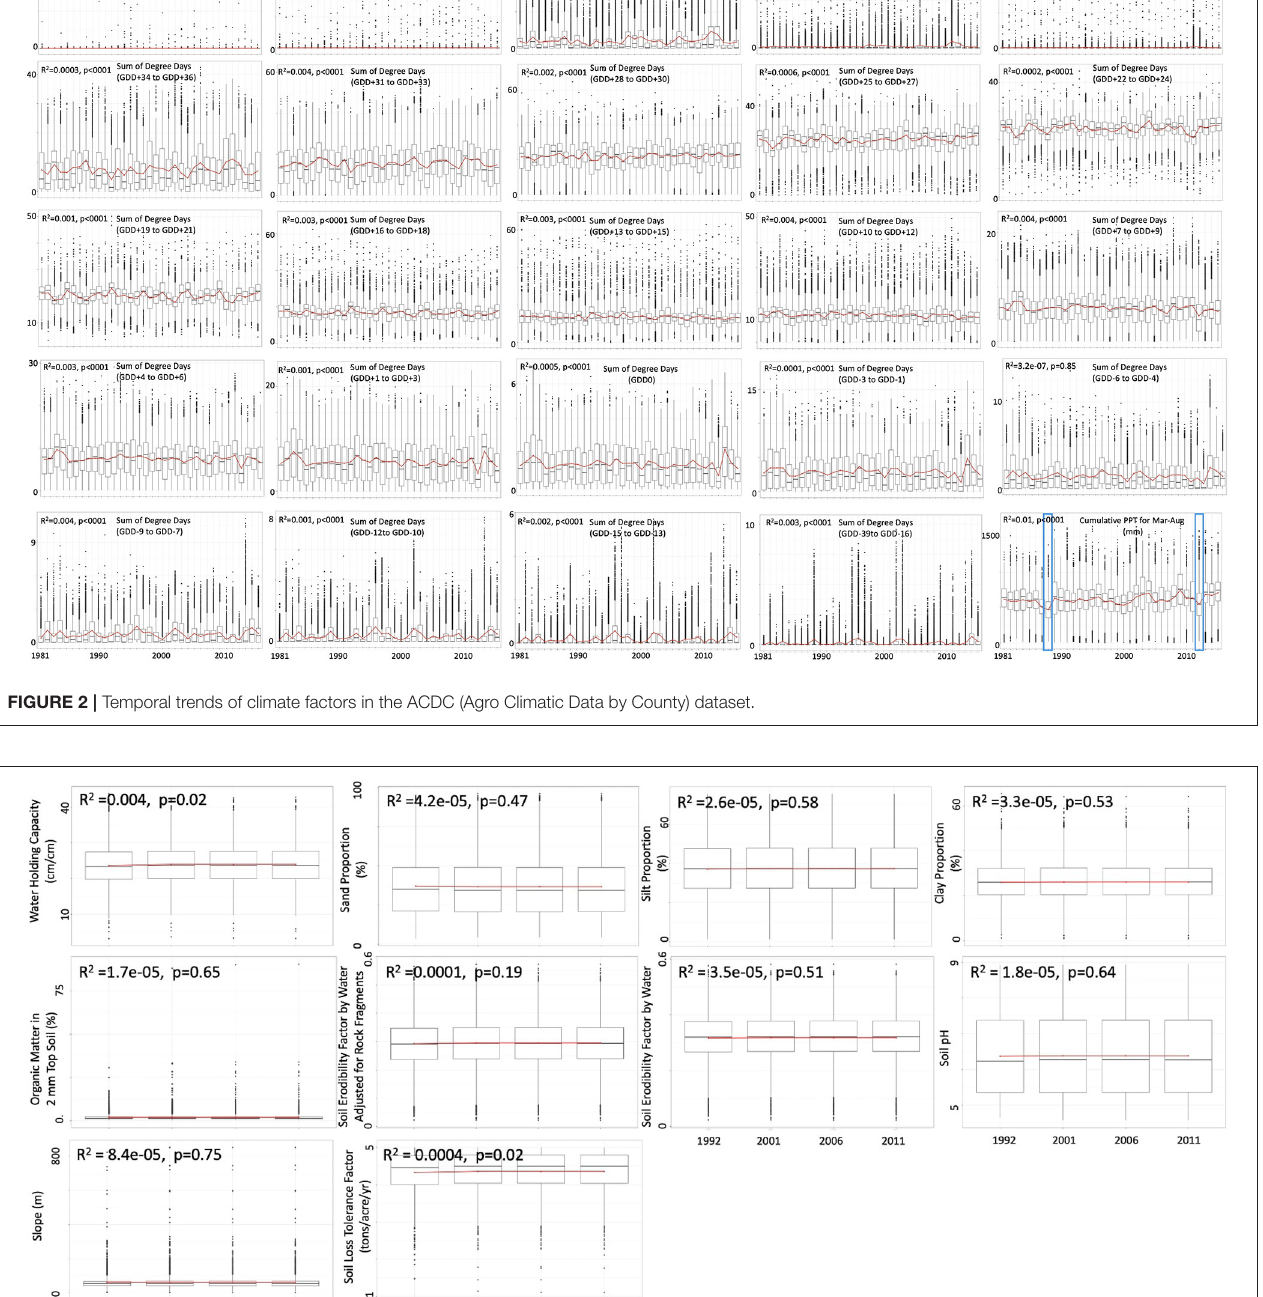
crops (corn, soybean, cotton, and wheat) grown in different regions (total 3,070 counties) across CONUS for 35-years (1981–